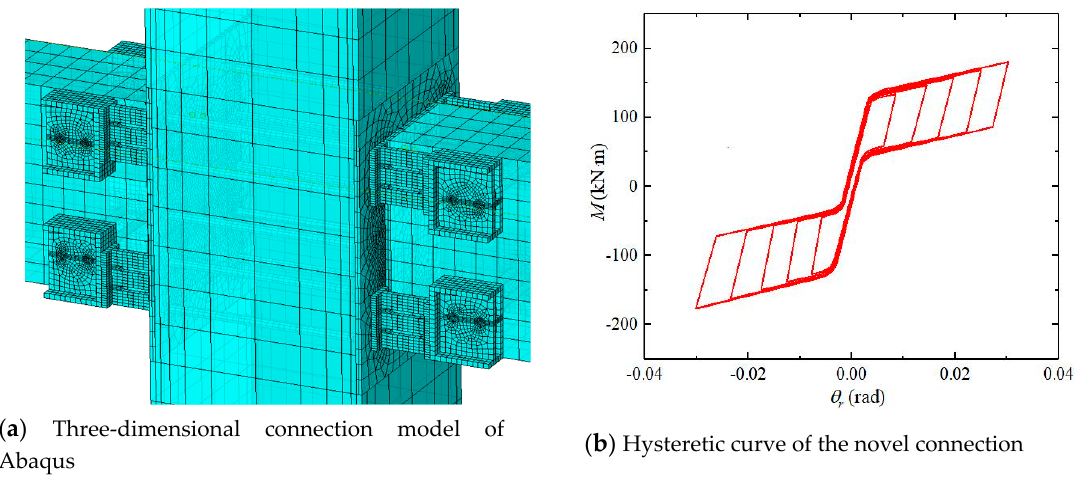
Figure 3. Three-dimensional model of hysteretic dampers and hysteretic curve of the novel joint.